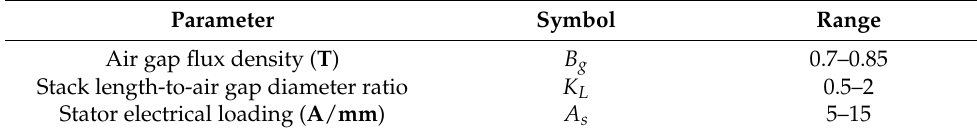
Figure 5. Flowchart of the design process. Table 2. SPM machine design specification